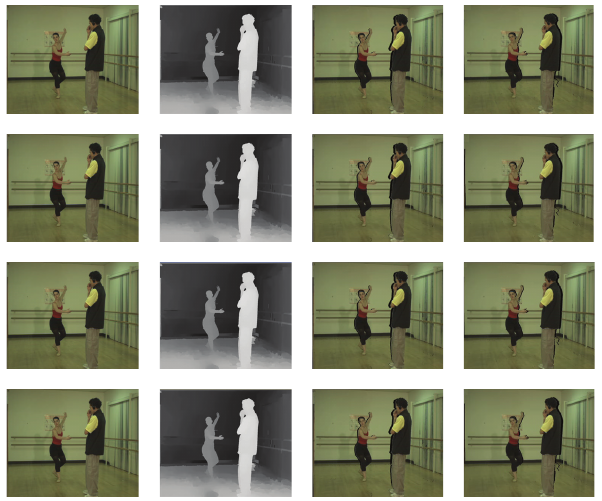
Figure 21: Image from Breakdance sequence. Left to right: color view, depth map, right view, left view. Top to bottom: SVC, PSS, ILPS, 3D-ILPS. All information